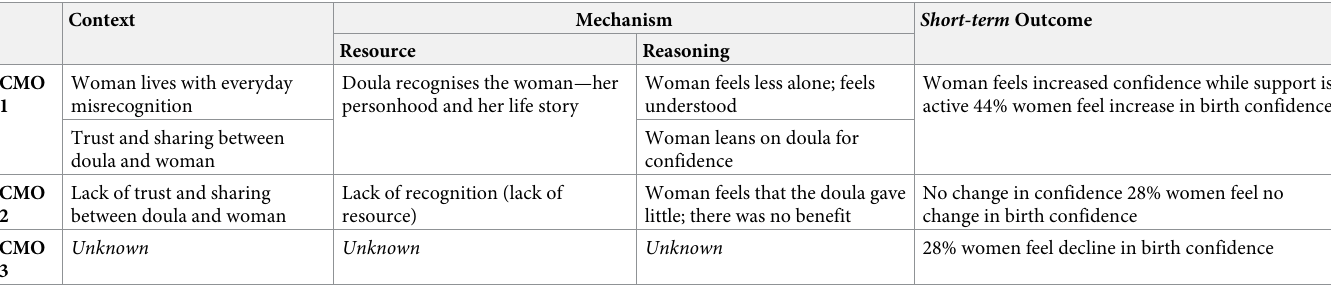
Table 6. CMO configurations 1–3, explaining short-term changes in women’s